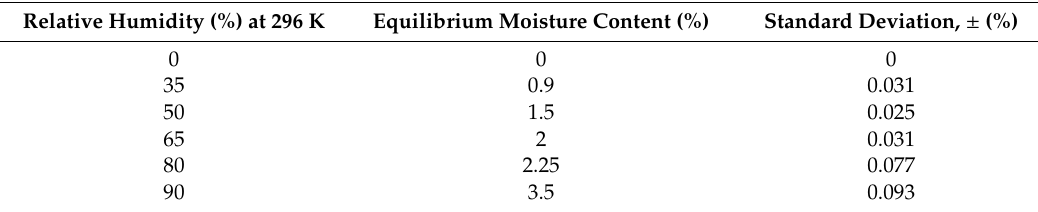
Table 1. Moisture contents in the function of relative humidity.